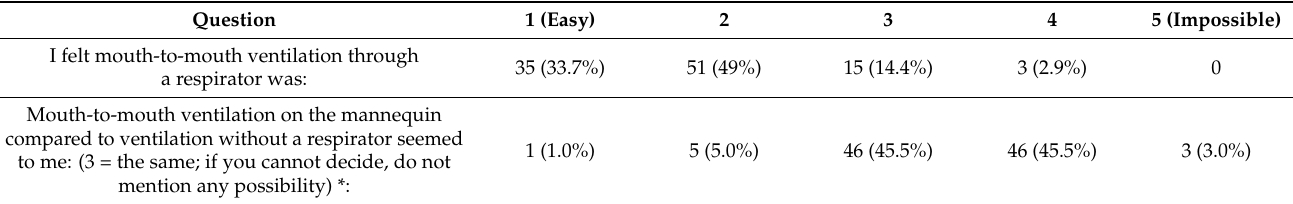
Table 3. Follow-up questionnaire ( n =